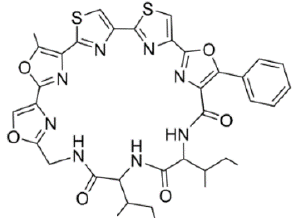
Figure 6. Structure of curacozole